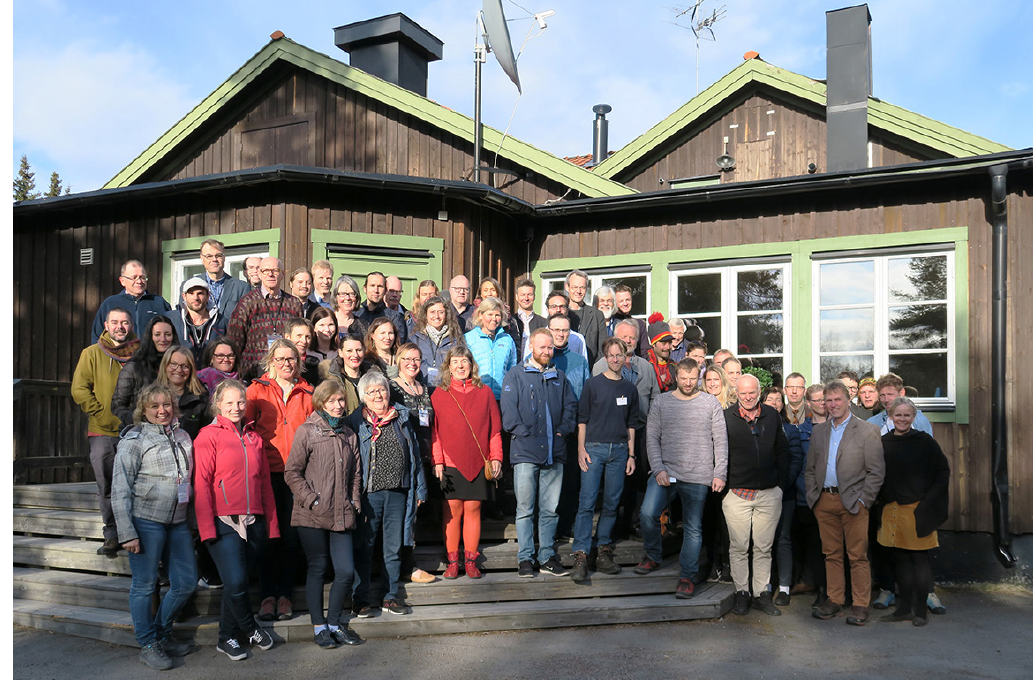
Fig. 1. Conference participants from Sweden, Finland, Norway, Russia, Canada, France and Italy (Photo: Hans Göran